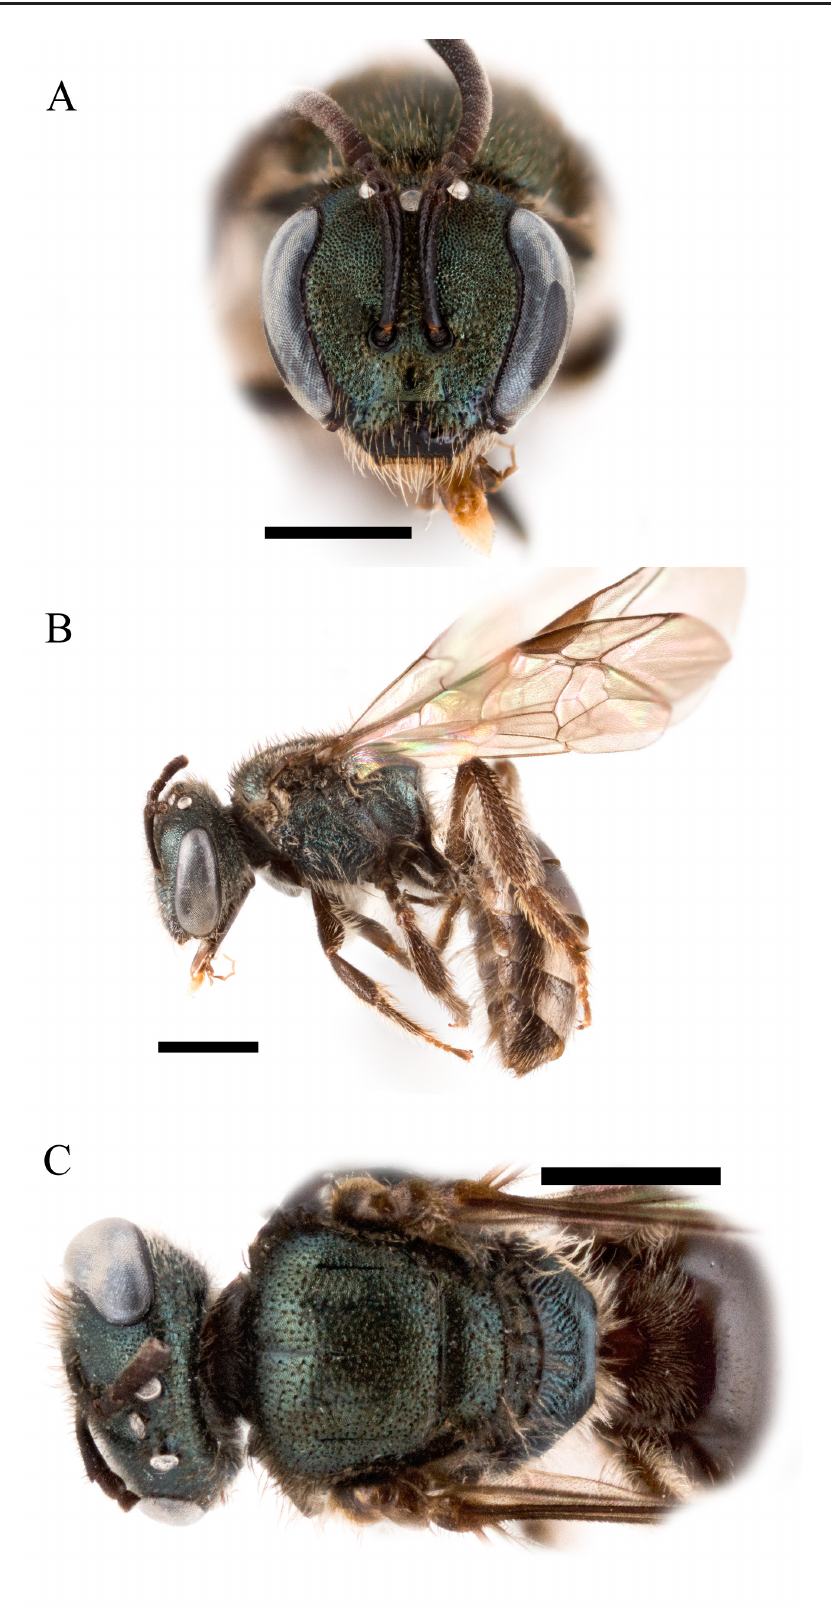
Fig. 1. Lasioglossum ( Dialictus ) kalinago sp. nov. Holotype (A) and paratype (B–C), ♀♀. A . Face. B . Lateral habitus. C . Dorsum of mesosoma. Scale bars = 1